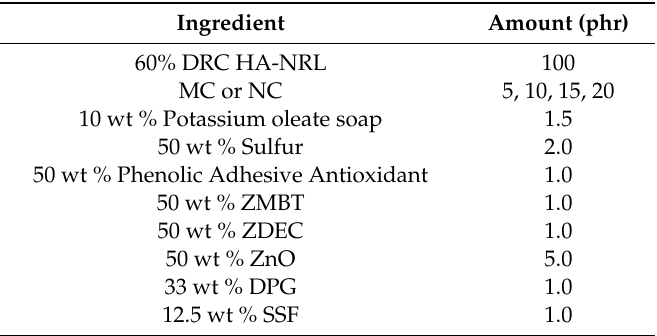
Table 1. Formulation of the natural rubber latex (NRL) compounds for the synthesis of reinforcing NRL foam